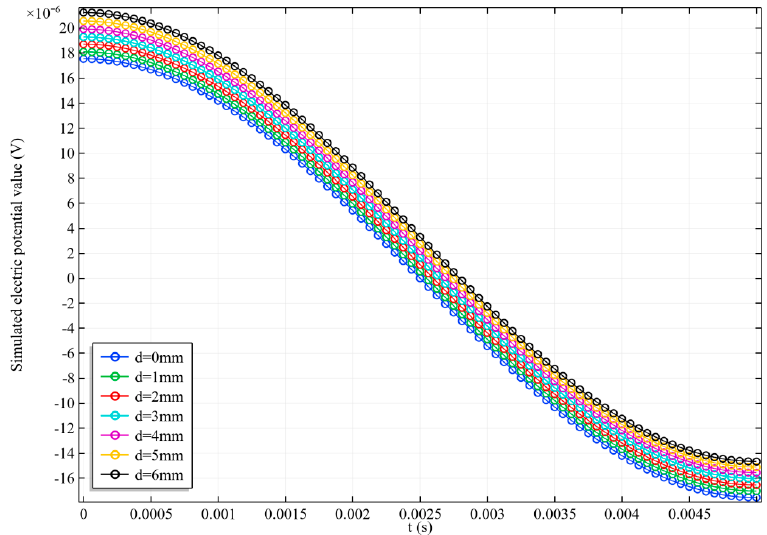
Figure 12. The electrode potential signal during a scanning cycle with different d values. mm0 = d